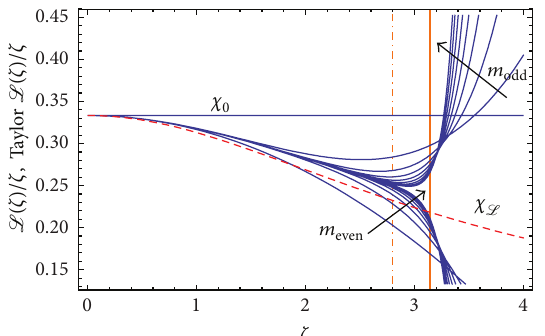
Figure 5: (colour online) Convergence of the Taylor series expan- sion of L (𝜁)/𝜁 representing the sum term in (36) up to odd and even labels increasing in the direction of the arrows up to 𝑚 max = 17 . The solid line belongs to 𝑚 max = 1(𝜒 0 ) . The thick dashed line shows = L (𝜁)/𝜁 . 𝜒 L